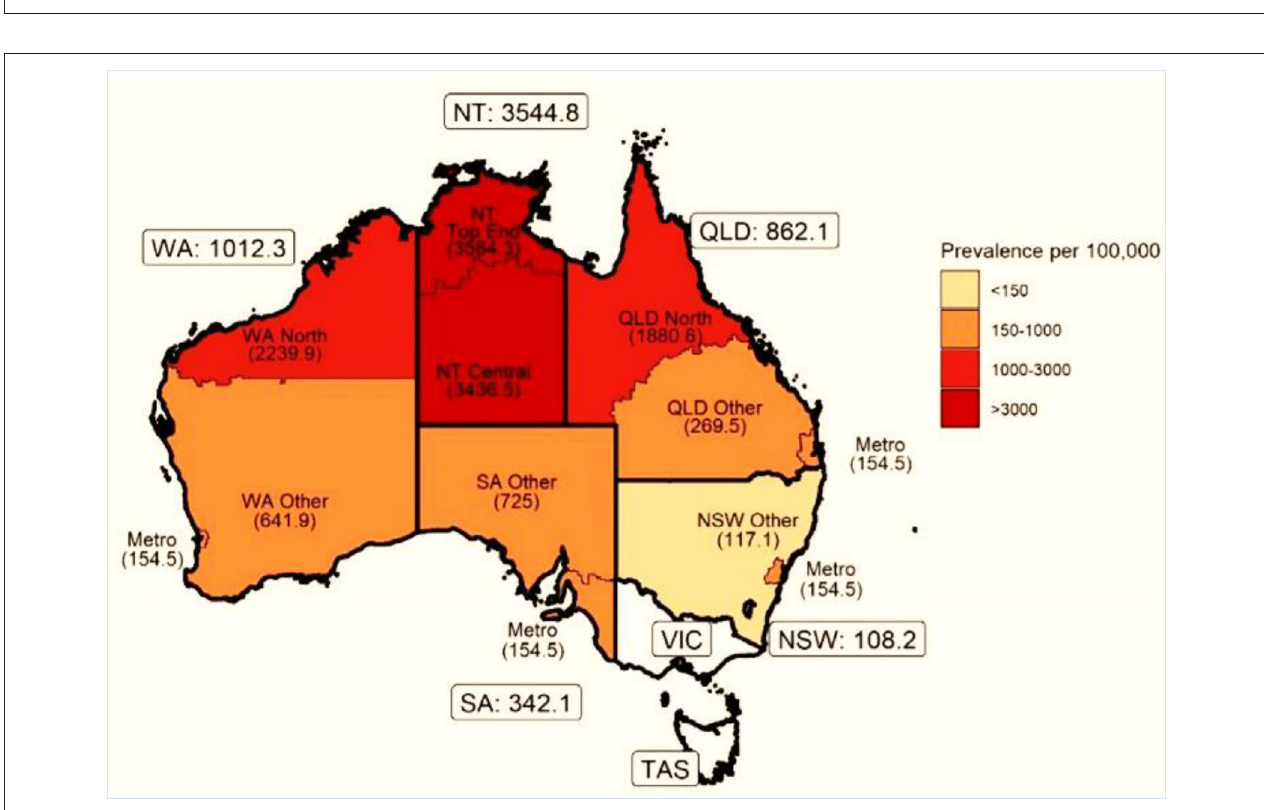
FIGURE 4 | Age-standardized prevalence (per 100 000) of ARF or RHD in indigenous populations by state and residence. NSW, New South Wales; NT, Northern Territory; QLD, Queensland; SA, South Australia; TAS, Tasmania; VIC, Victoria; WA, Western Australia [modified from